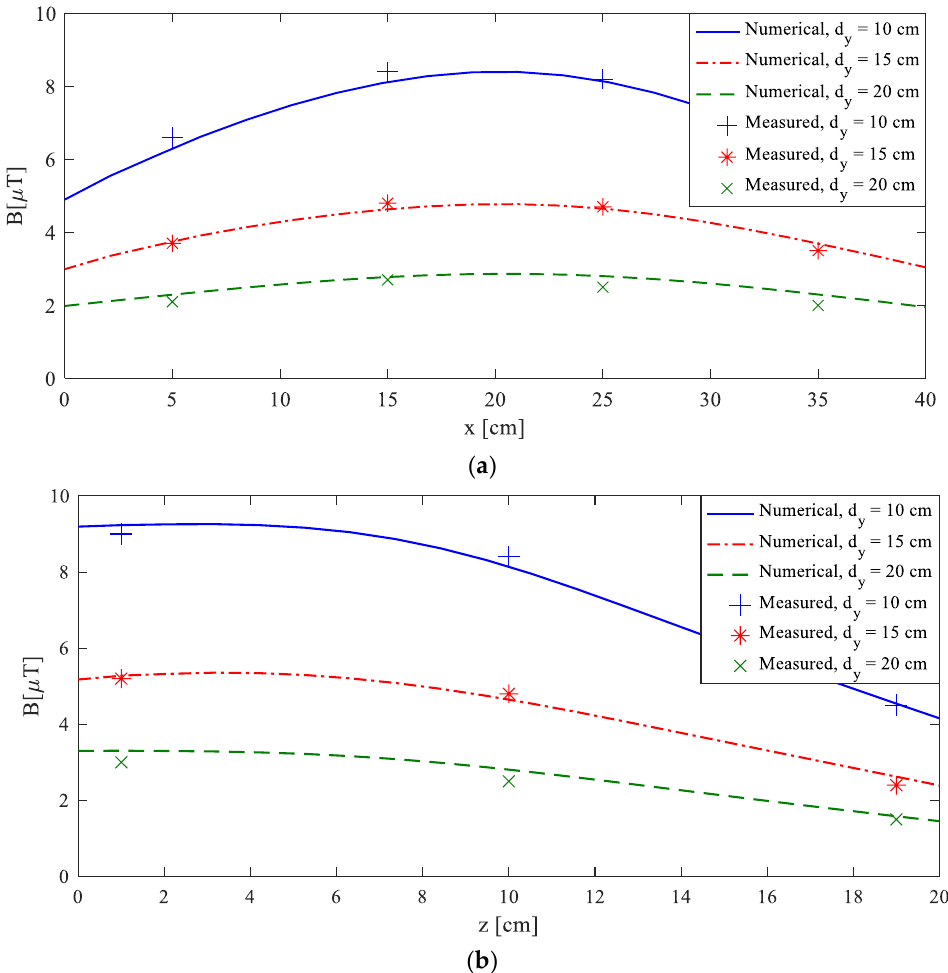
Figure 17. Calculated and measured magnetic flux density along lines l a ( a ) and l b ( b ) (see Figure 16).